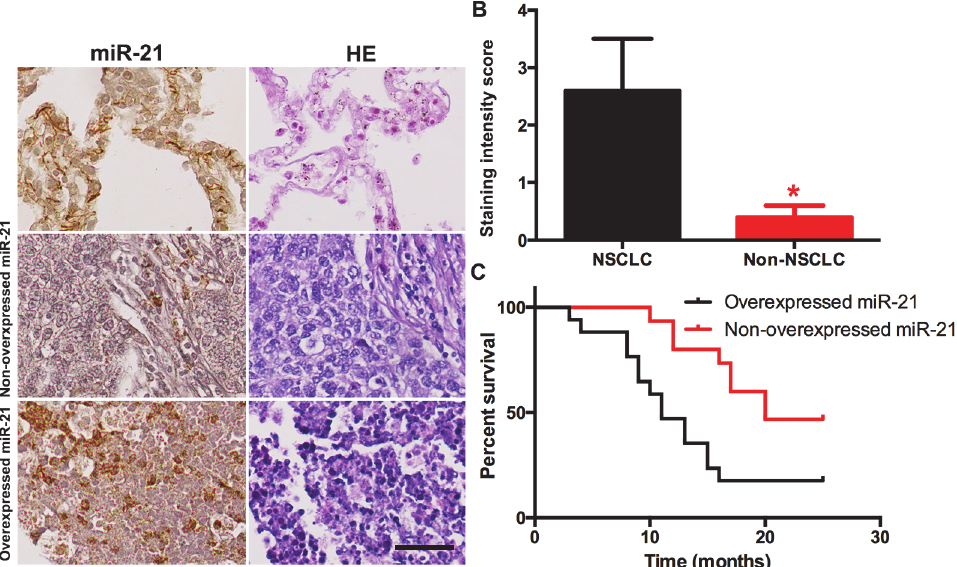
Fig 1. Overexpression of miR-21 in NSCLC patients. (A) ISH was used to detect the miR-21 in a TMA with 34 NSCLC and 10 normal lung samples. Left panel was ISH and right panel was HE staining. (B) The staining intensity score was higher in NSCLC patients compared with normal subjects. (C)